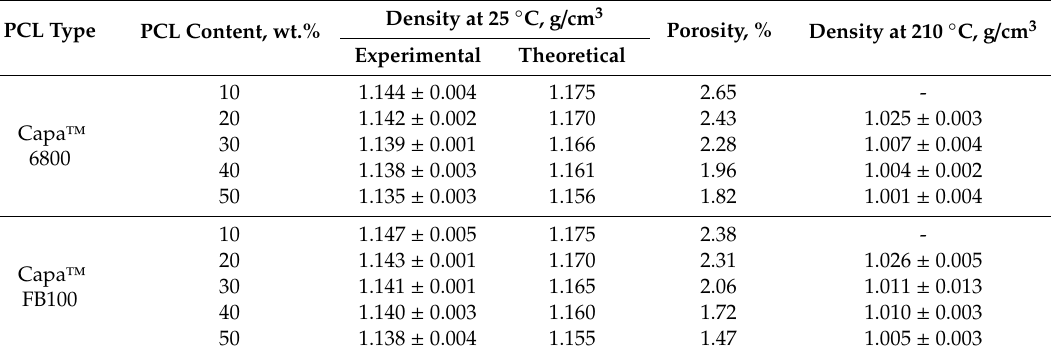
Table 2. Density of reclaimed rubber / poly( ε -caprolactone)